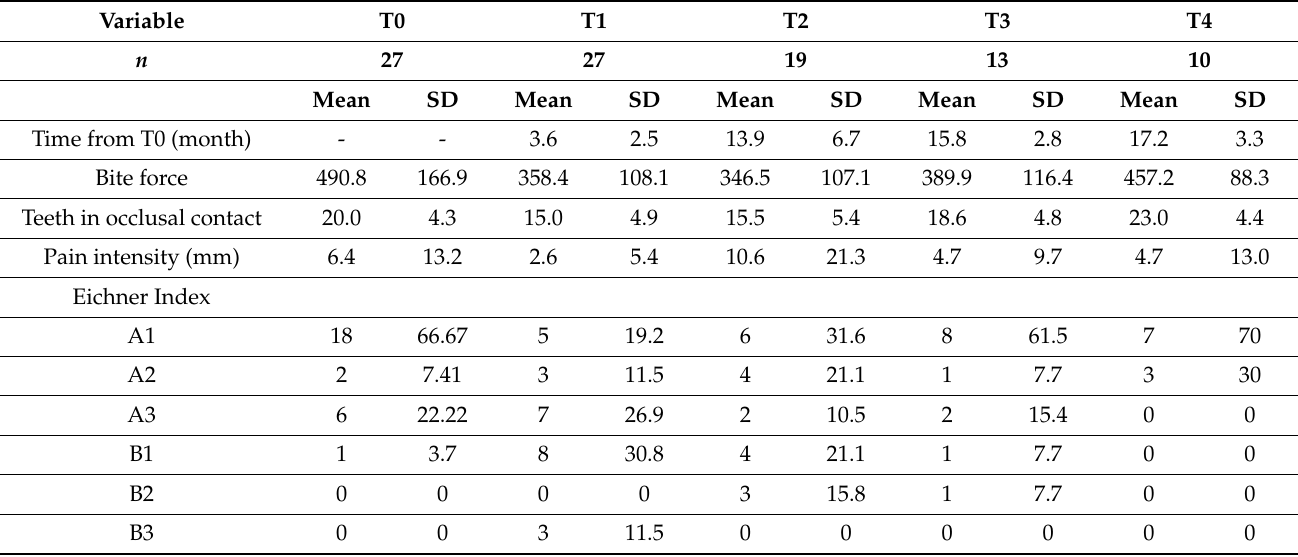
Table 1. Bite force, occlusal contact and pain intensity at the different treatment phases.